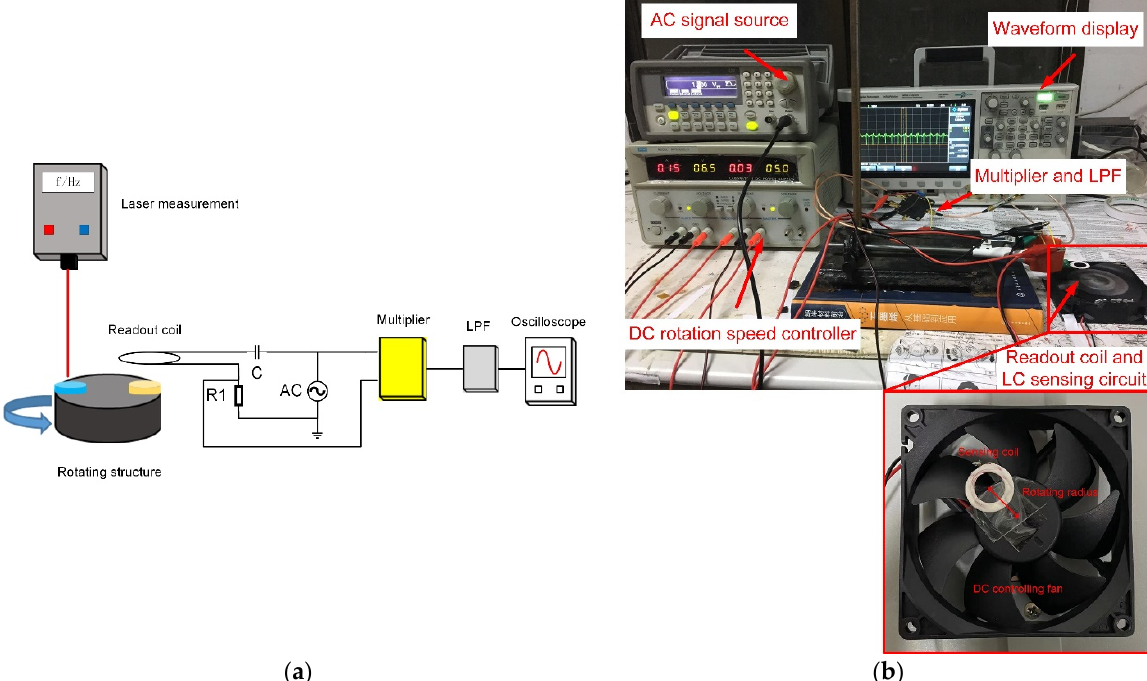
Figure 6. Rotational speed measurement system: ( a ) rotational speed measurement system schematic; ( b ) rotational speed measurement setup.